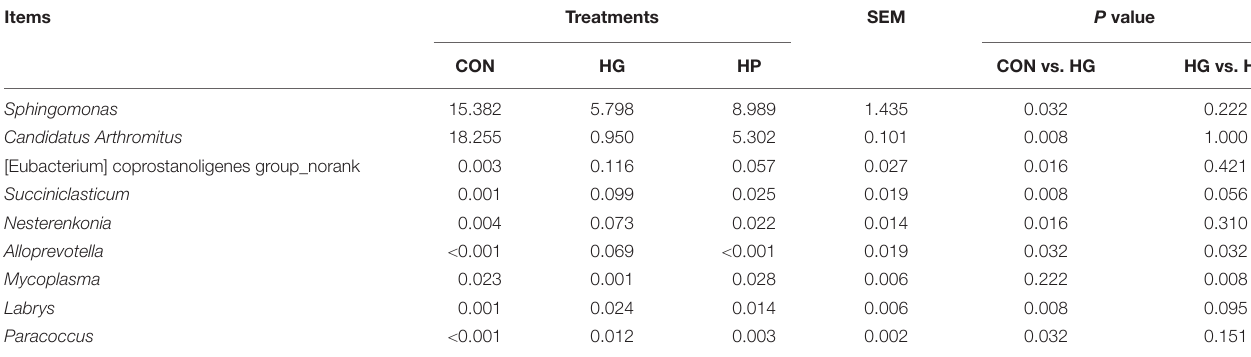
FIGURE 6 | Correlation networks between the affected microbiota and metabolites in the ileal mucosa of Hu sheep between the CON and HG groups (A) and the HG and HP groups (B) . Only correlation coefficients with P < 0.05 and the | r | > 0.6 were adopted to construct the correlation networks. TABLE 1 | Relative abundance of major genera ( > 0.01% in at least one group) in the ileal mucosal microbiota of Hu sheep fed CON, HG, and HP